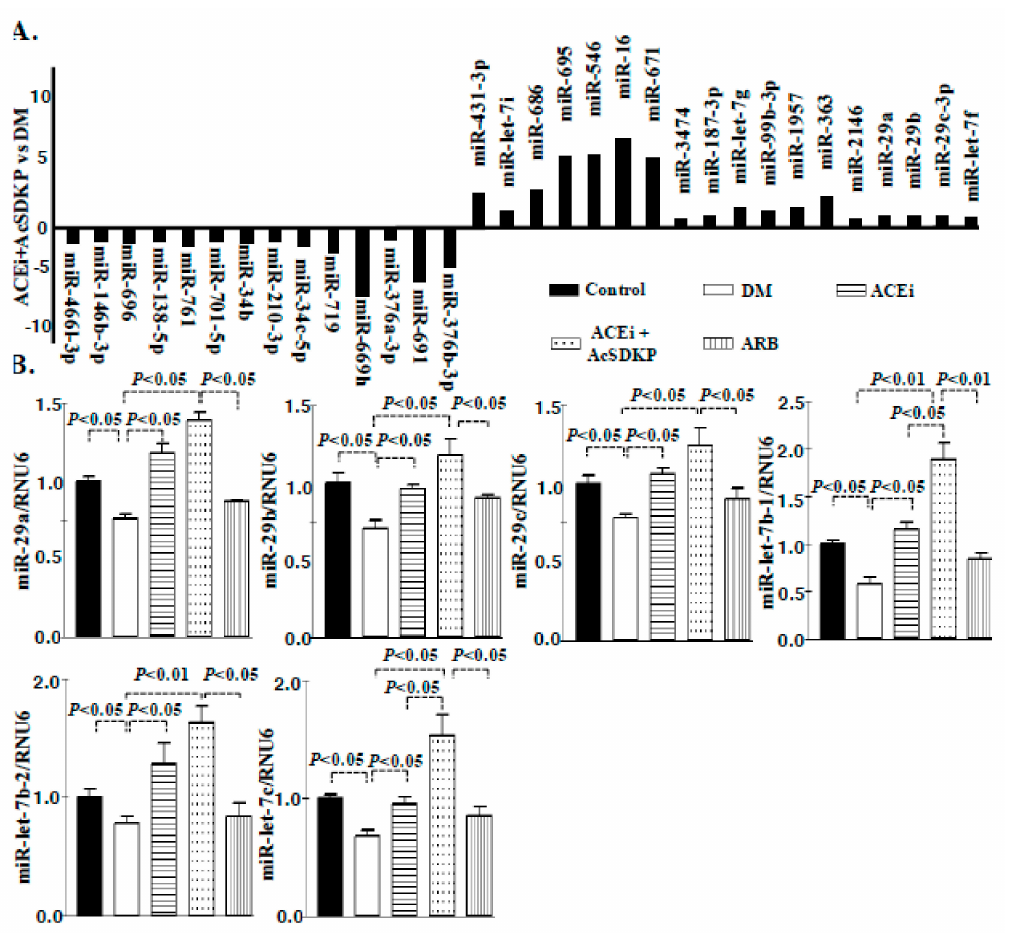
Figure 2. miRome analysis reveal up-regulated expression of miR-29 and miR-let-7 family members in the kidneys of ACE inhibitor or combination treated diabetic mice. ( A ) microRNA-array analysis in the diabetic group vs ACEi + AcSDKP treatment in diabetic mice revealed alteration in the expression level of pro and antifibrotic microRNAs. N = 3 were analyzed in each group. ( B ) miR-29 and miR-let-7 family members emerged as important regulatory antifibrotic molecules and validation by the real time PCR using specific primers in the kidney of control, DM, ACEi, combination treatment and ARB group. N = 6 were analyzed in each group. Hs_RNU6 was used as internal control to normalize the expression data. Data in the graph are presented as mean ± SEM. One-way Anova Tukey test was performed for calculation of statistical